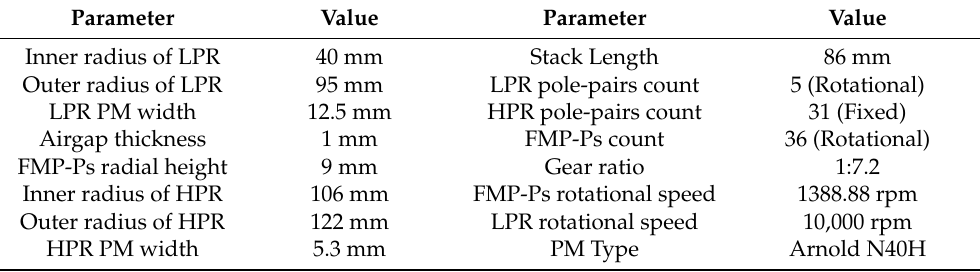
Table 5. Baseline design parameters and specifications. LPR: Lower number of poles; HPR: Higher number of